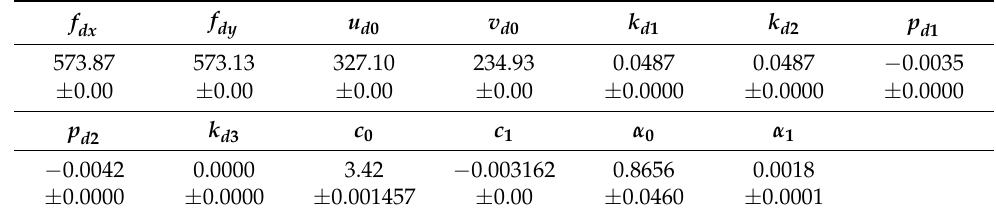
Table 3. Depth sensor intrinsic